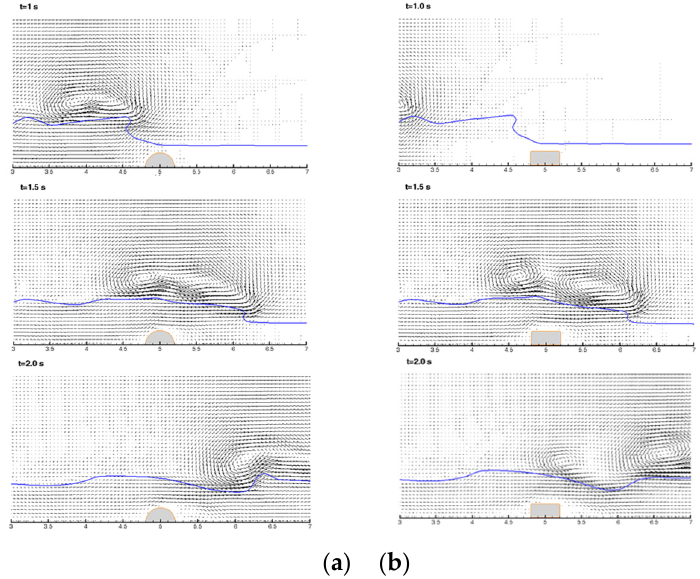
Figure 16. Velocity distributions of a dam ‐ break wave over submerged structures at different times: ( a ) semicircular cylinder and ( b ) rectangular cylinder.